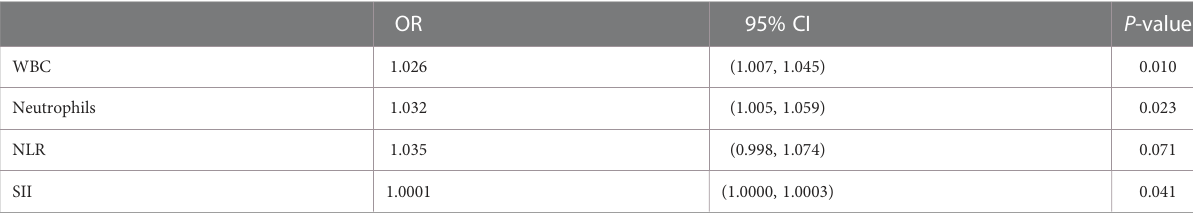
TABLE 4 The associations between in fl ammatory biomarkers and sleep disturbance.